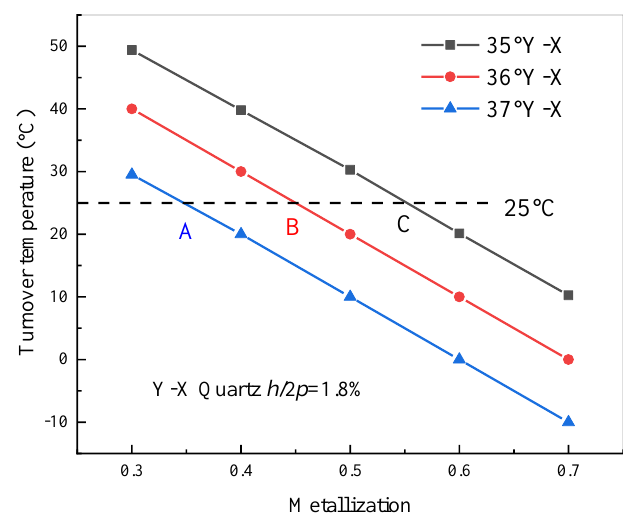
Figure 3. Turnover temperature of quartz with different cut angles and IDT with the metallization ratio.